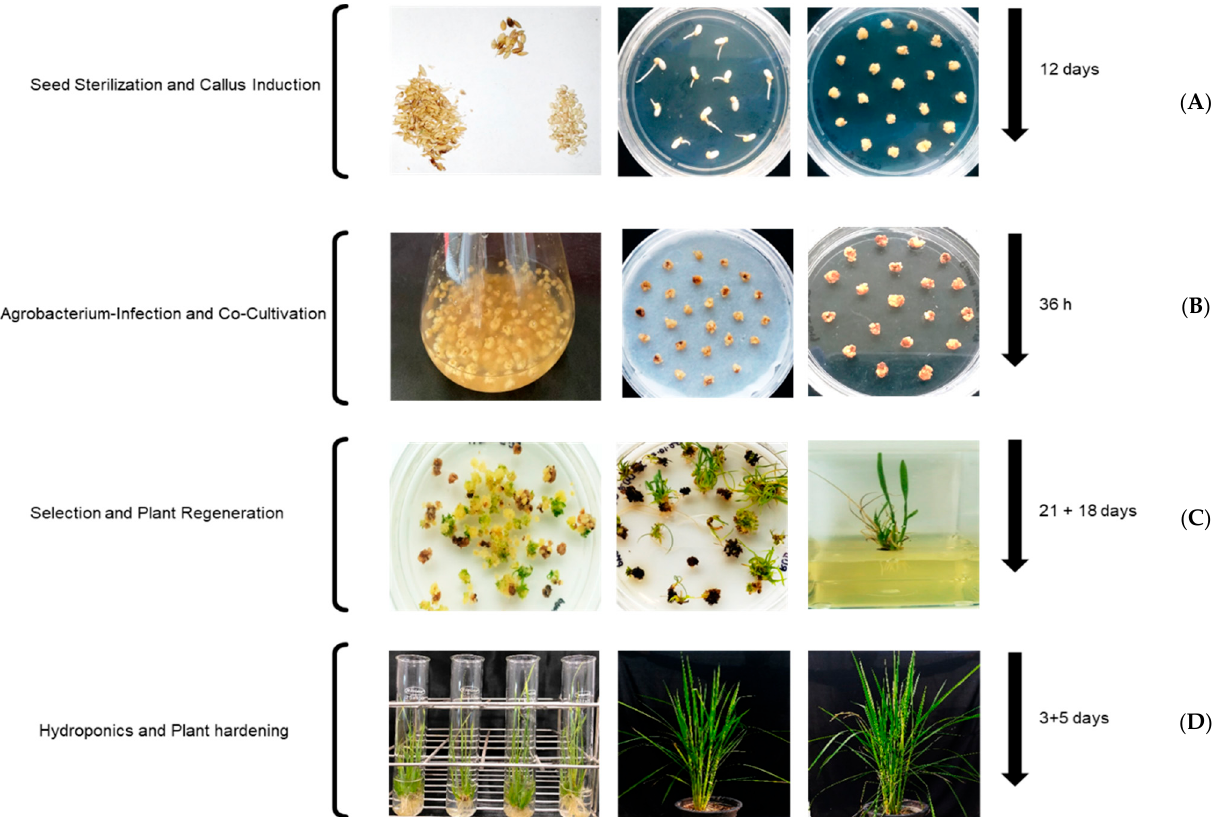
Figure 1. The stepwise Agrobacterium -mediated rice transformation and regeneration. ( A ) Dehusked seeds were surface-sterilized before callus induction on callus induction media. ( B ) Calli were Agro - infected and co-cultivated with Agrobacterium tumefaciens . ( C ) The selection of transformed calli on hygromycin selection and their regeneration for shoot and root development. ( D ) Plantlets were grown hydroponically before hardening in soil, and subsequently grown till maturity.